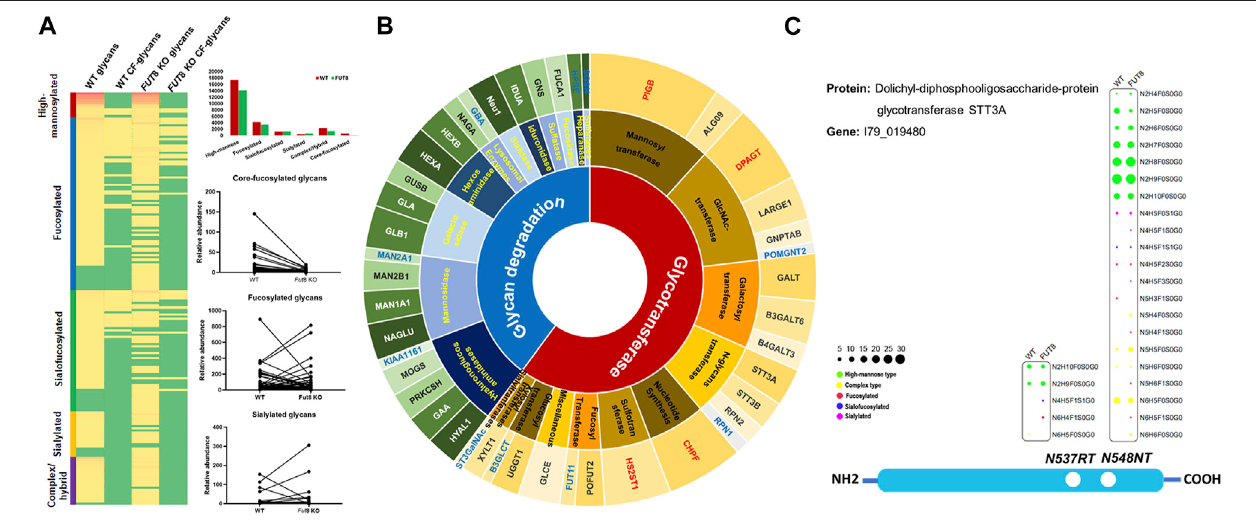
FIGURE4| Thechange ofglycosylation and expression ofglycosylation related enzymesin FUT8KO CHO cells. (A) Thechange ofglycanson theglycoproteins in the WT and FUT8KO CHO cells. (B) The expression of glyco-related enzyme in the WT and FUT8KO CHO cells. (C) The glycosylation of N-glycan transferase dolichyl- diphosphooligosaccharide-protein glycosyltransferase subunit STT3A.